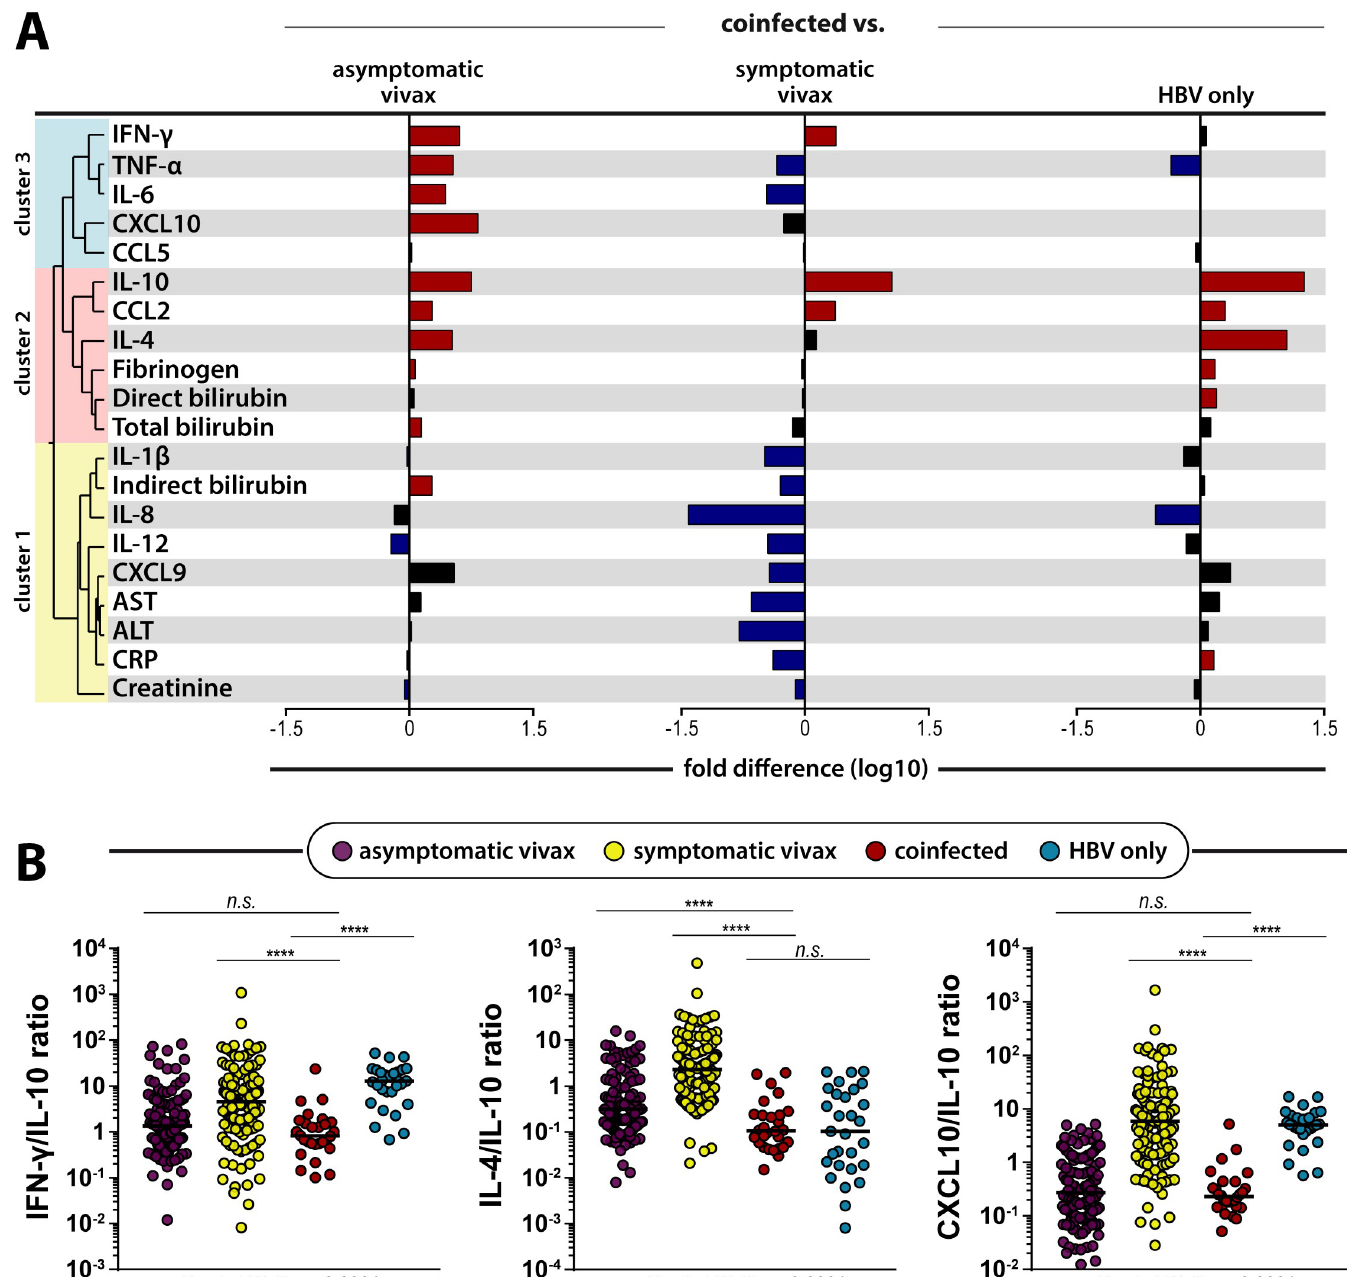
Fig 2. Effect of coinfection in different biomarker concentrations and its associations to monoinfected individuals. ( A ) Pattern of variables expressed differentially between symptomatic vivax malaria, and HBV patients against coinfected individuals. Dendrograms represent hierarchical distance observed from Fig 1A, and its respective clusters. ( B ) Scatter-plots of the IL-4/IL-10, CXCL10/IL-10, and the IFN- γ /IL-10 ratio, which has been shown to accurately depict the inflammatory imbalance in severe vivax malaria